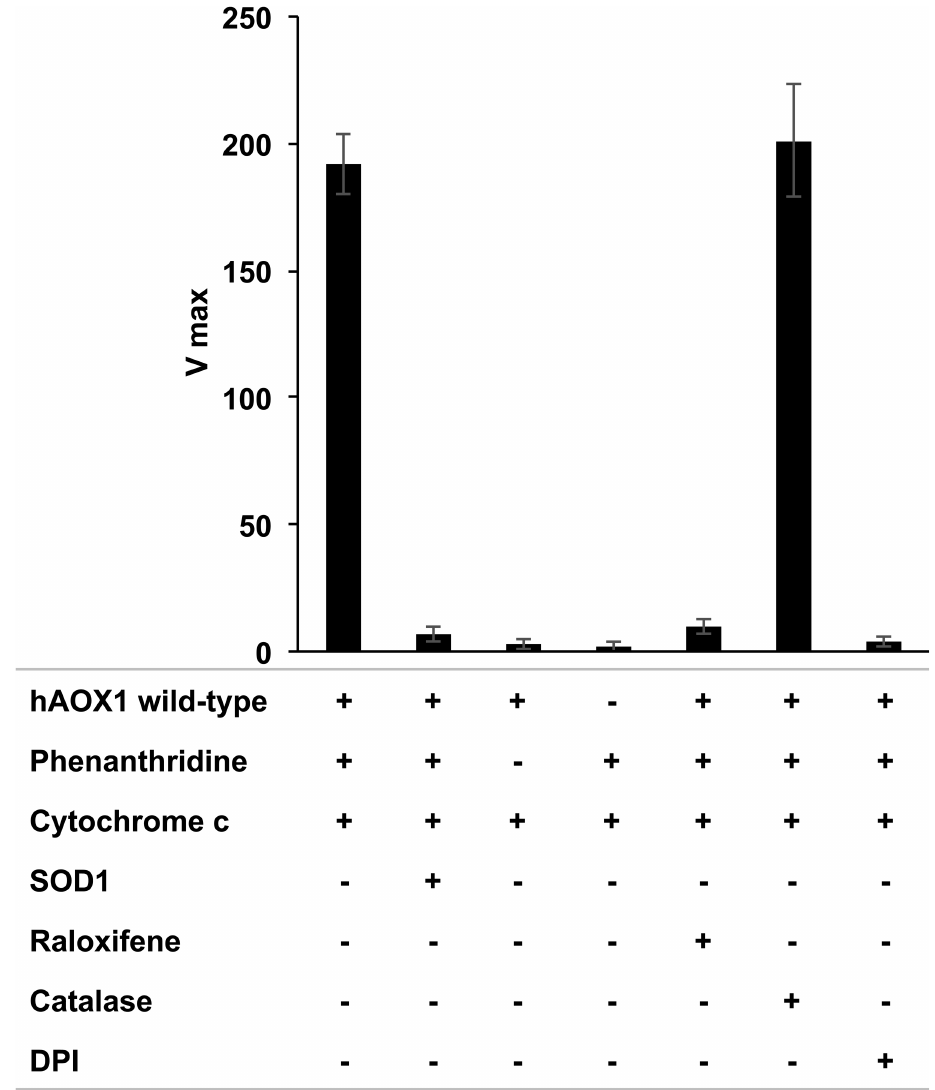
Fig 6. Superoxide production by hAOX1 wild-type. Superoxideproduction of enzymes were calculated by followingthe reduction of 100 μ M cytochrome c at 550 nm in the presence of 50 μ M phenanthridine